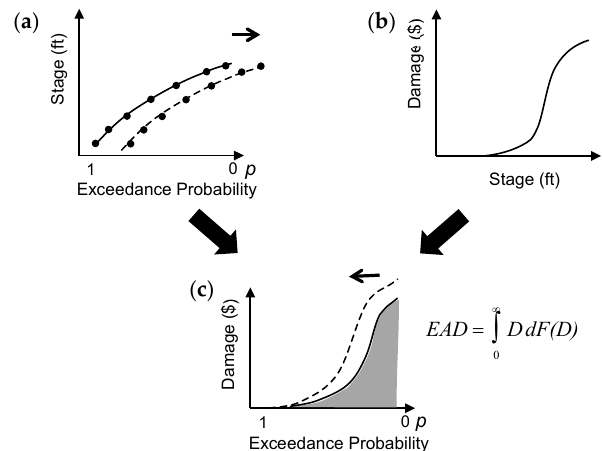
Figure 4. Basis of the Expected Annual Damages (EAD) computation used in CVFPP Hydrologic Engineering Center’s Flood Damage Assessment software (HEC-FDA) model (modified from [27]): ( a ) Stage-exceedance curves, where the solid line indicates the stage-exceedance curve calculated in HEC-FDA from the 99.9-, 10-, 4-, 2-, 1-, 0.5-, and 0.2-percent exceedance events calculated using historical gauge data (points). The dashed lines and points indicate how the stage-probability curves were shifted to assess the sensitivity of EAD to di ff erent climates; ( b ) Stage-damage curve, where the solid line indicates the curve calculated in HEC-FDA from discrete exceedance events calculated using historical gauge data; ( c ) Damage-exceedance curves calculated in FDA by combining ( a , b ).